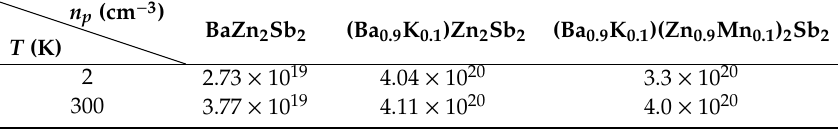
Table 2. Calculated carrier concentrations ( n p ) of three typical